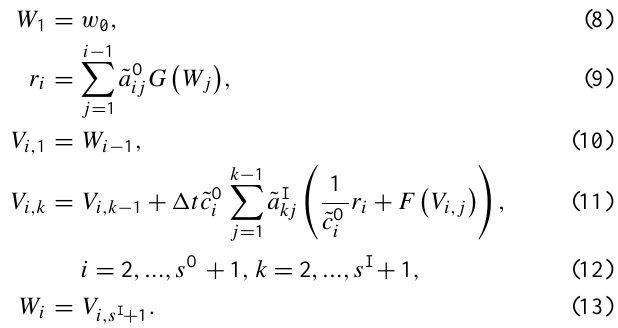
algorithm computing an approximate solution w 1 for time t